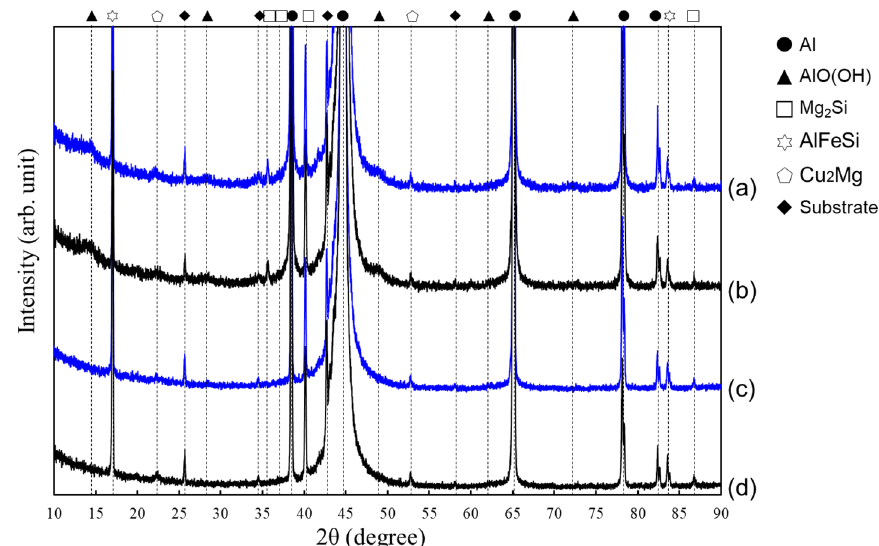
Figure 10. Glancing ‐ angle X ‐ ray diffraction (GAXRD) profiles of ( a , b ) uncoated specimen and ( c , d ) specimen subjected to steam coating at 180 °C for 1 h. ( a , c ) before the saltwater immersion test and ( b , d ) after the saltwater immersion test at 35 °C for 48 h.